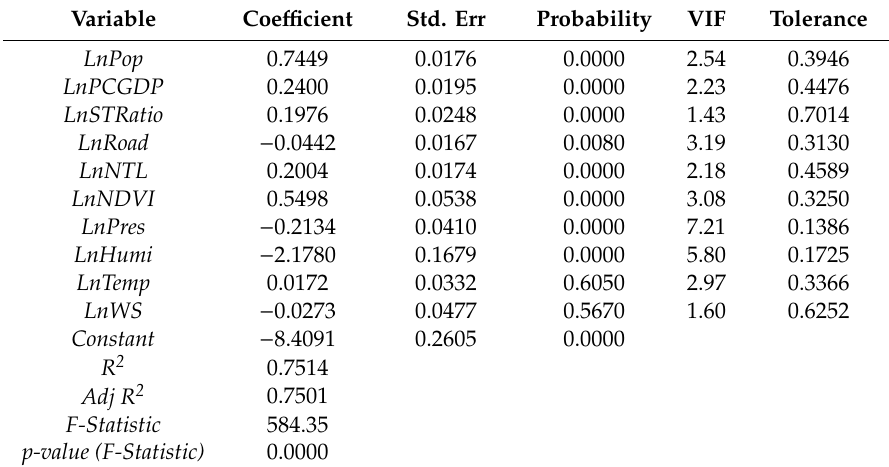
Table 3. Pooled least squares